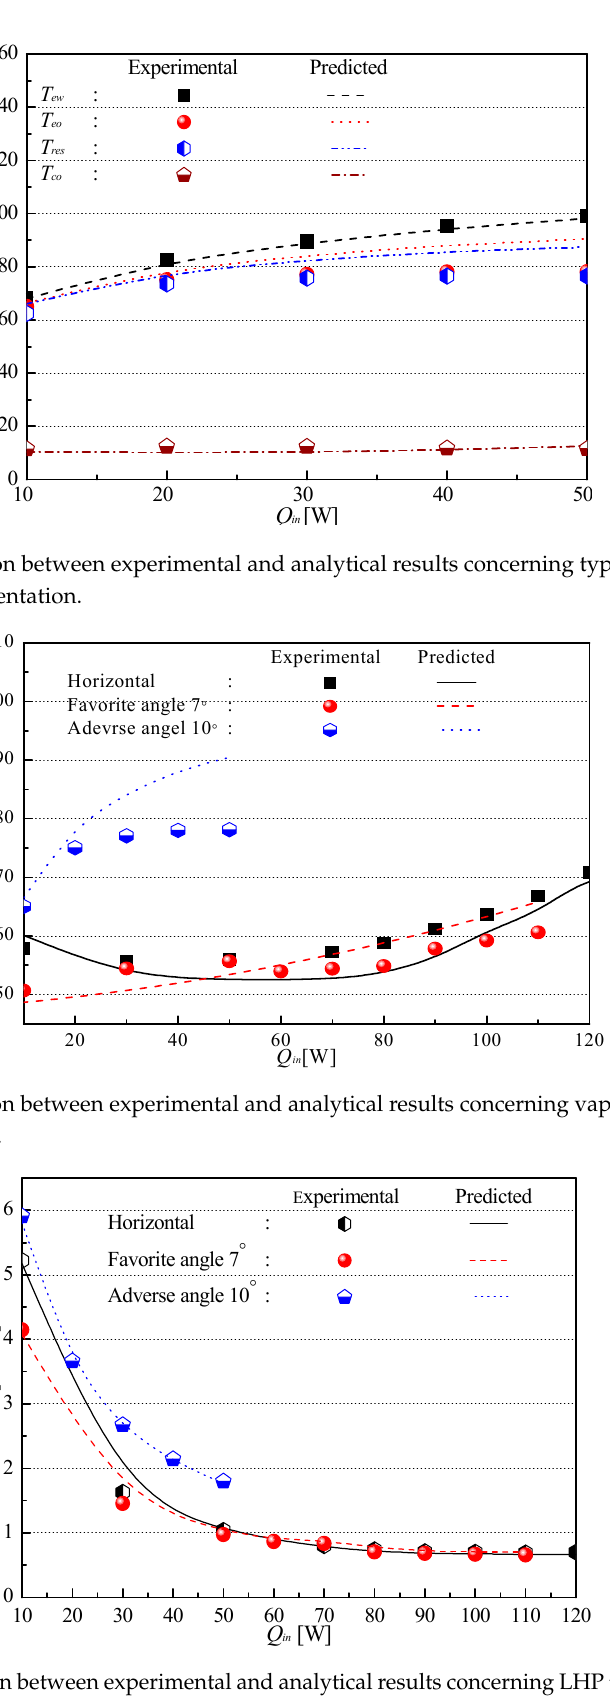
Figure 14. Comparison between experimental and analytical results concerning LHP thermal resistance in the three orientations.